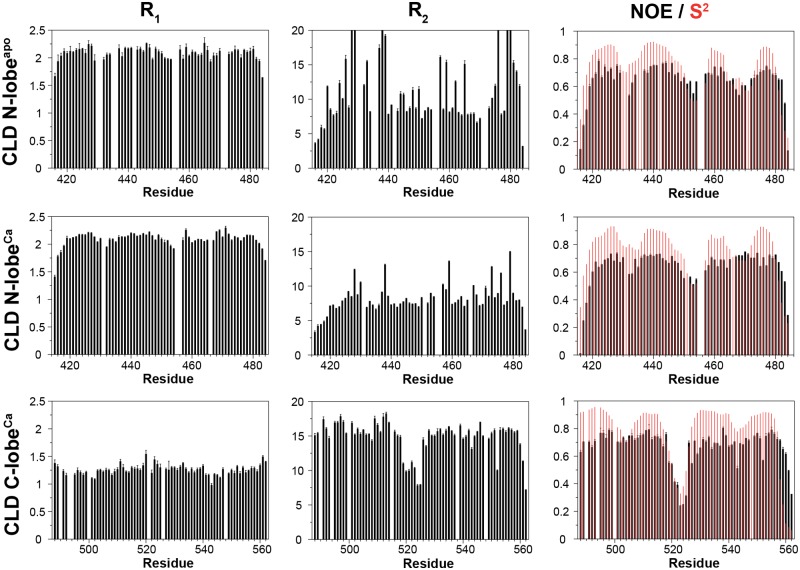
15N relaxation rate constants and the {1H}-15N NOE for CLD N-lobeapo, CLD N-lobeCa and CLD C-lobeCa.Order parameters, calculated by the RCI method and shown as red bars, have been included in the panels representing the heteronuclear NOE. The vertical axes have been scaled identically for all proteins.